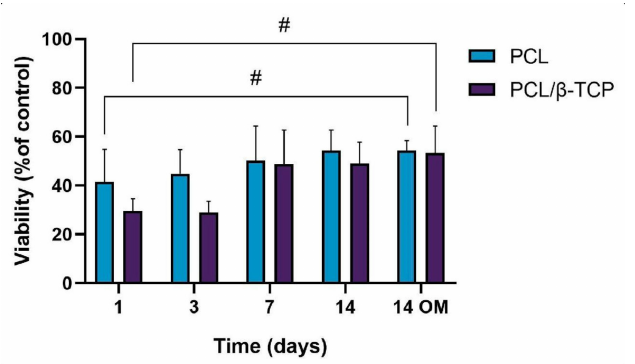
Figure 6. Cellular metabolic activity using the AlamarBlue assay on ah -BM-MSCs seeded on both PCL and PCL/ β -TCP scaffolds at different time periods. The mean percentage viability was calculated and normalized to the viability of cells growing on plastic (TCPs) (positive control). Bars represent standard deviations of the mean. # Significant differences between the bracketed groups at different time periods.